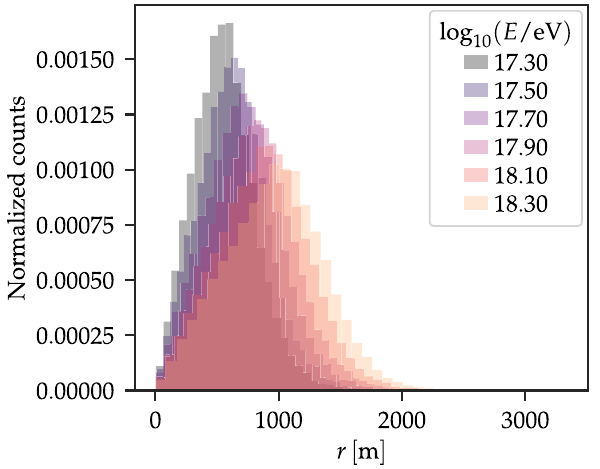
Fig. 6 Normalized distributions of station distances to the shower axis in a simulated hexagonal array, for a 50–50% mixture of proton and iron, for zenith angles below 48 ◦ , and for different log 10 ( E / eV ) -bins of width 0 . 2